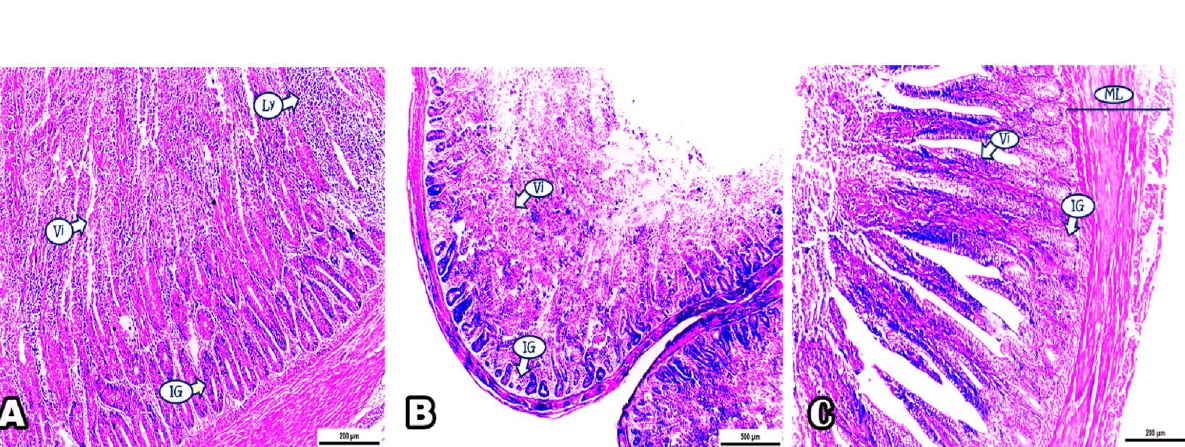
Figure 1. ( A – C ) Photomicrographs demonstrating the outcomes of ZnONPs supplement on the intestinal tissue of examined broilers. In 40 mg ZnONPs group, ( A ) Noticeable desquamation of the intestinal villi, increase in cell production of intestinal villi (Vi), intestinal gland (IG), and aggregated lymphocytes (Ly). In 60 mg ZnONPs group, ( B ) Marked degeneration, apoptosis of intestinal villi (Vi), and atrophy of intestinal gland (IG). In control group ( C ) Typical microvilli (Vi), intestinal gland (IG), and intact muscular layer (ML). (H&E staining, A&C:100 × magnification, scale bar = 200 μm, B: 40 × magnification, scale bar = 500